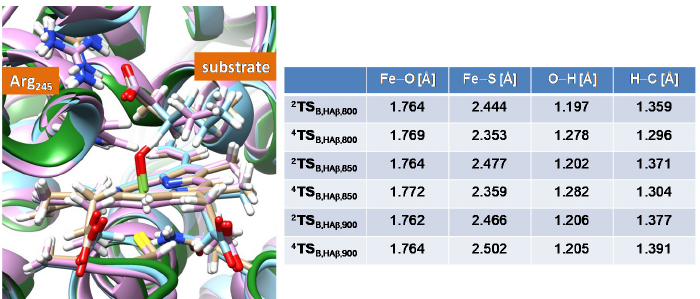
Figure 10. QM/MM optimized geometries of hydrogen atom abstraction transition states from the C β ‒ H position of substrate in the doublet and quartet spin states for snapshots Sn 800 , Sn 850 and Sn 900 . Fe ‒ O, Fe ‒ S, O ‒ H and H ‒ C distances given in angstroms, while the left-hand-side gives an overlay of the doublet spin optimized structures.